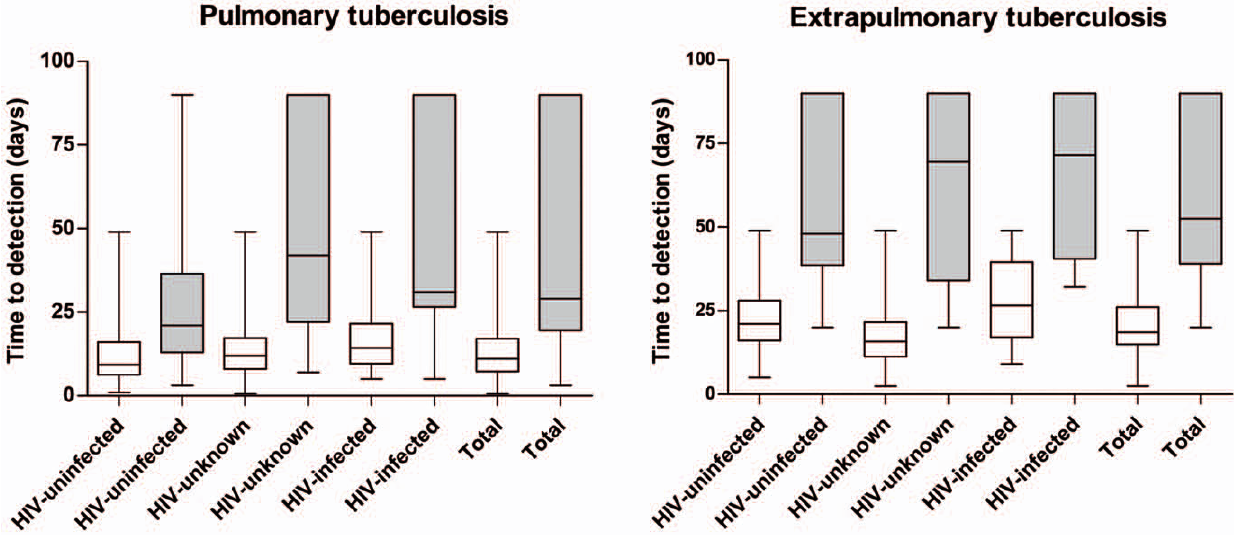
Figure 2. Comparative Time to Detection (TTD) of culture-positive specimens on solid (LJ) medium (grey bar) or with automated liquid (BacT/alert) (white bars) medium in active pulmonary and extrapulmonary TB patients according to their HIV status. TTD in days: median (IQR). doi:10.1371/journal.pone.0043739.g002 PLOS ONE |